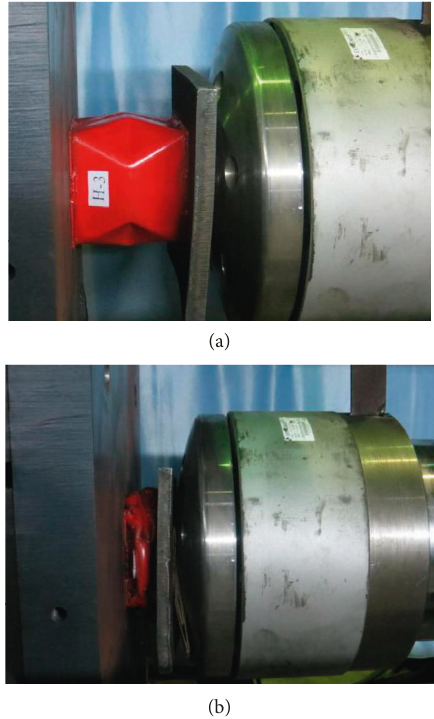
Figure 12: Impact test of crash boxes. (a) Installation of single crash box. (b) Impact result of single crash